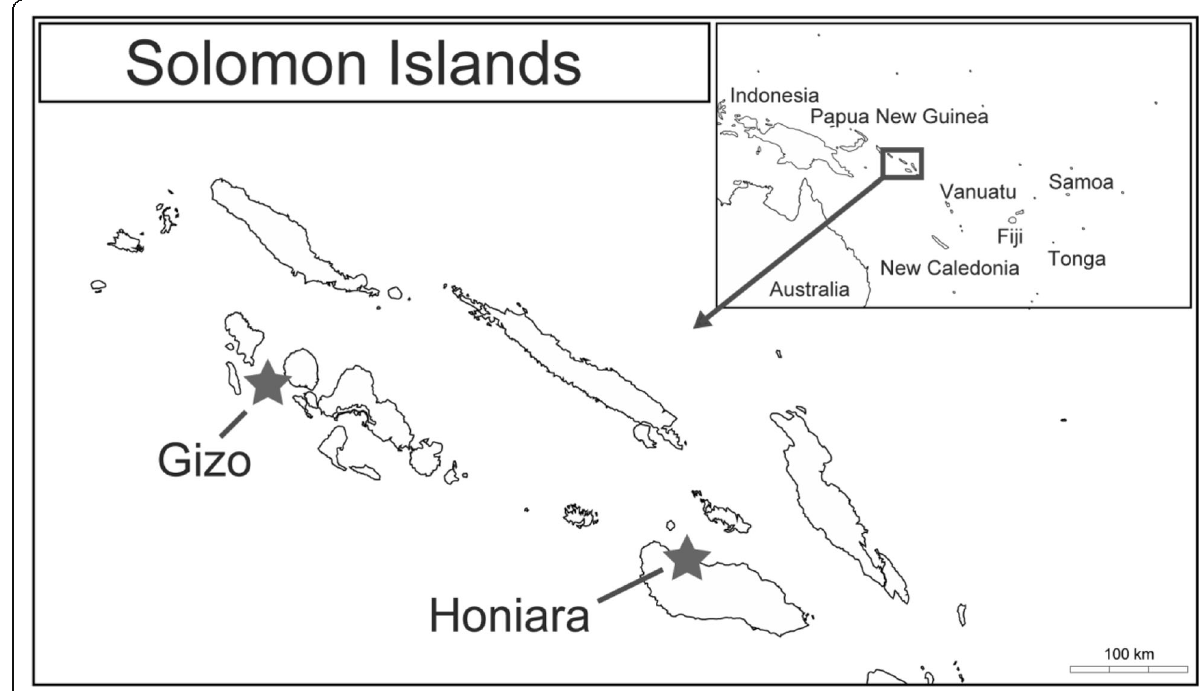
Fig. 1 Map of Solomon Islands. A partial map of Solomon Islands, showing Honiara and Gizo, where the study was performed is